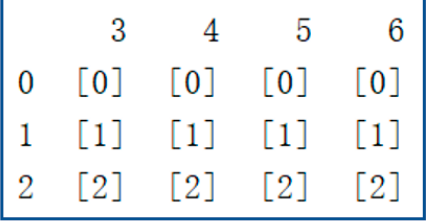
Figure 4. Top right (running result of Python).